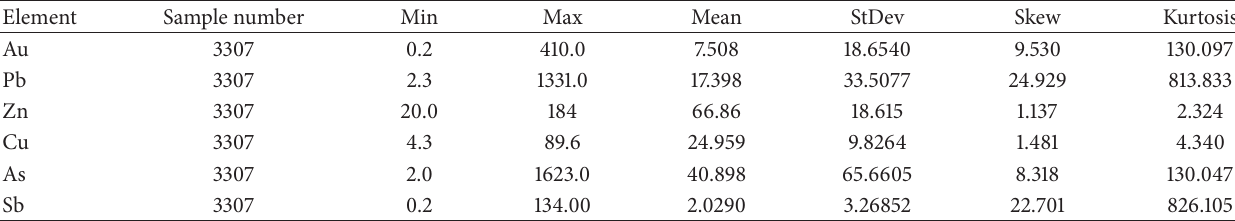
Table 1: Parameters of soil geochemical elements in the given area of Qinghai.